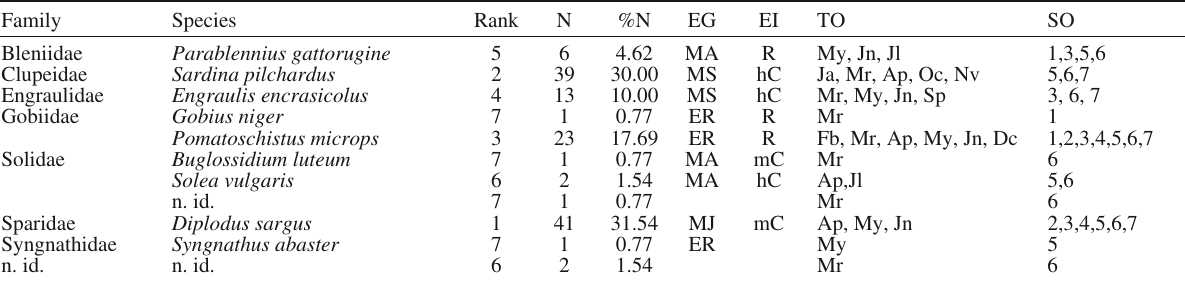
Table 1. – List of fish larvae family and species caught during the study, showing rank by number (based on the individual species abundance); N, total abundance; %N, percentage contribution; EG, classifications of ecological guilds (MA, marine adventitious species; MS, marine seasonal migrants; MJ, marine juvenile species; ER, estuarine resident species); EI, species economic importance (R, recreational value; hC, high commercial value; mC, minor commercial value); TO, temporal occurrence (Ja, January; Fb, February; Mr, March; Ap, April; My, May; Jn, June; Jl, July; Sp, September; Oc, October; Nv, November; Dc, December); SO, spatial occurrence (sampling stations 1-7).